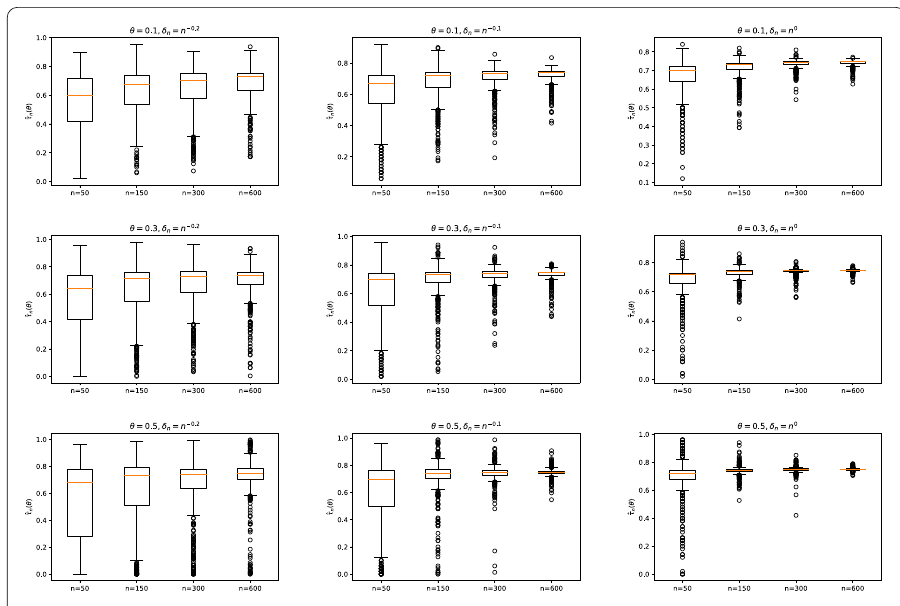
Figure 3 Boxplots of ˆ τ n ( θ ) with different values of parameters θ and δ n in the case τ 0 = 0.75